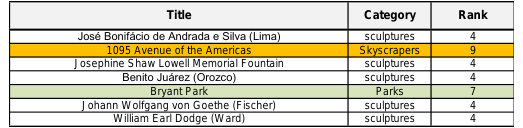
Table 7. 7 Wikipedia entries (landmarks) with ranking scores